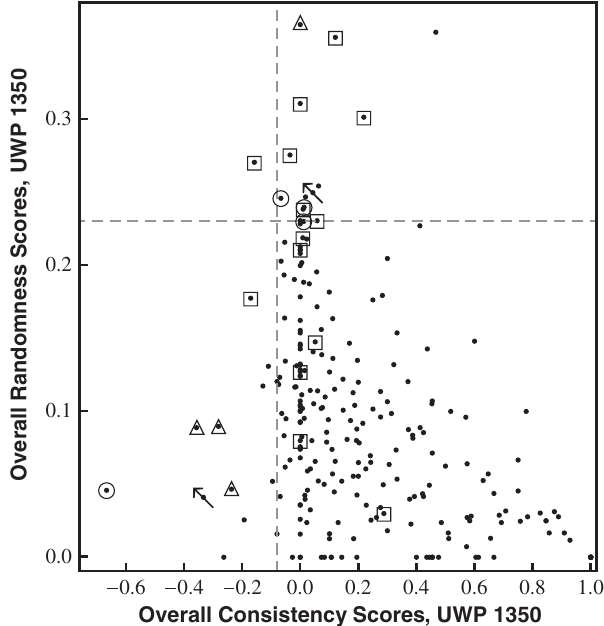
FIG. 4. Overall randomness [ R defined in Eq. (6)] vs over- total defined in Eq. (3)] for the 250 statements in all consistency [ C total the UWP 1350 subsample. The dashed lines indicate the strong randomness cut of 0.23 and the strong (incorrect) consistency cut of (cid:1) 0 : 08 discussed in Sec. III. Points outlined with symbols are discussed in Sec.